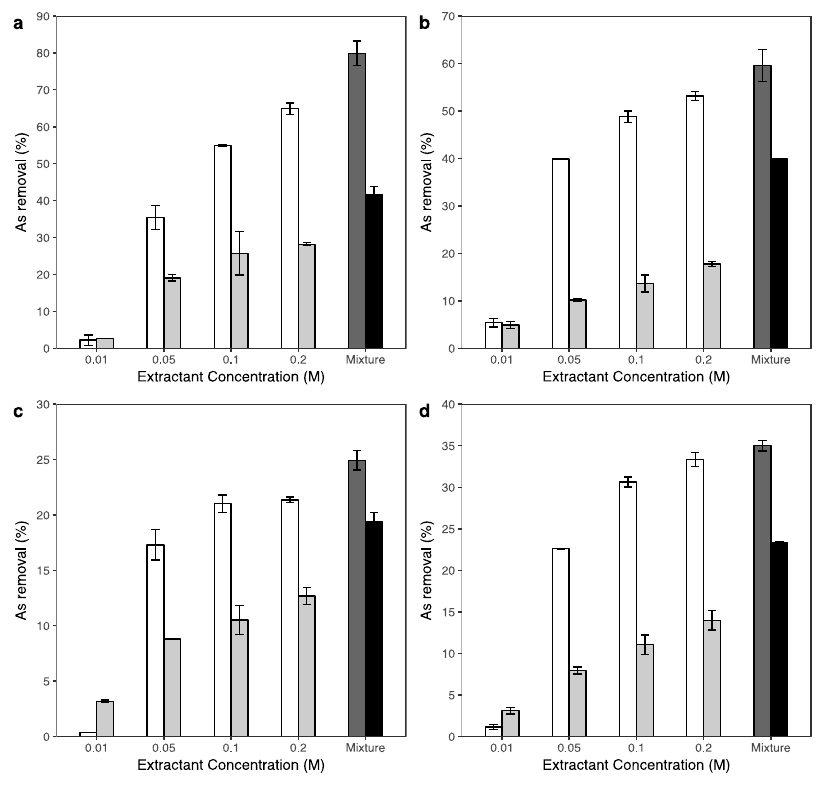
Figure 2. Effect of oxalic and citric acid in various concentrations, mixtures of oxalic (0.2 M) + ascorbic (0.1 M), and mixtures of citric (0.2 M) + ascorbic (0.1 M) on arsenic removal from river bed sediment ( a ), mangrove forest soil ( b ), paddy soil ( c ) and aquaculture farm sediment ( d ).